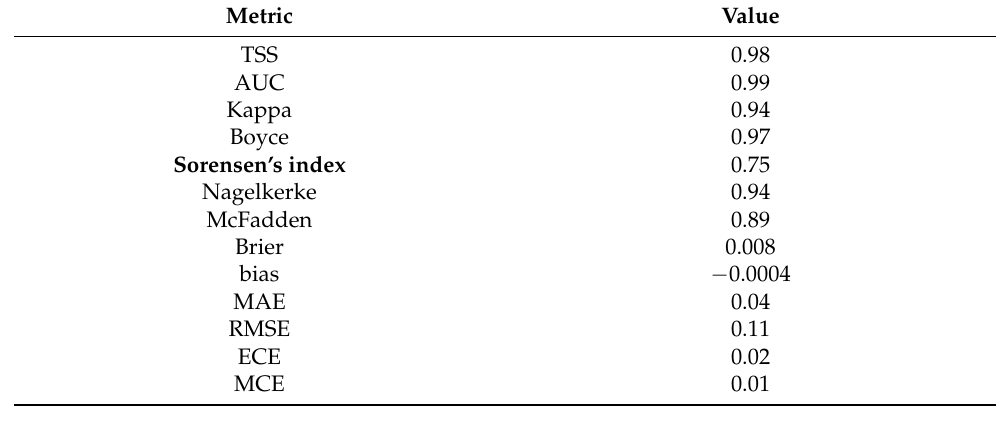
Table 1. Accuracy metrics and indices for the Species Distribution Model of Pterois miles in the Mediterranean Sea.